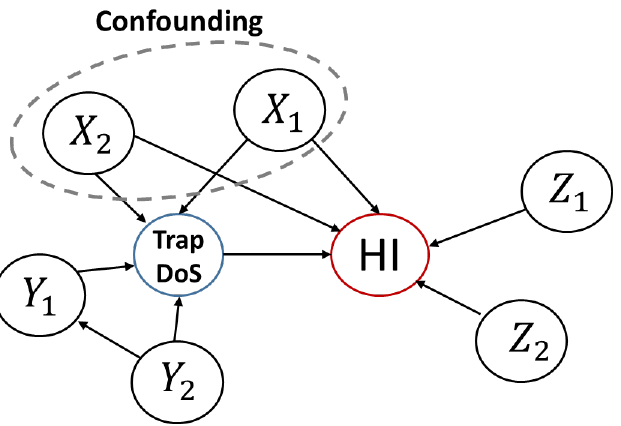
are are the sources of the traps, and are the sources 𝑋𝑋 𝑖𝑖 𝑌𝑌 𝑖𝑖 𝑍𝑍 𝑖𝑖